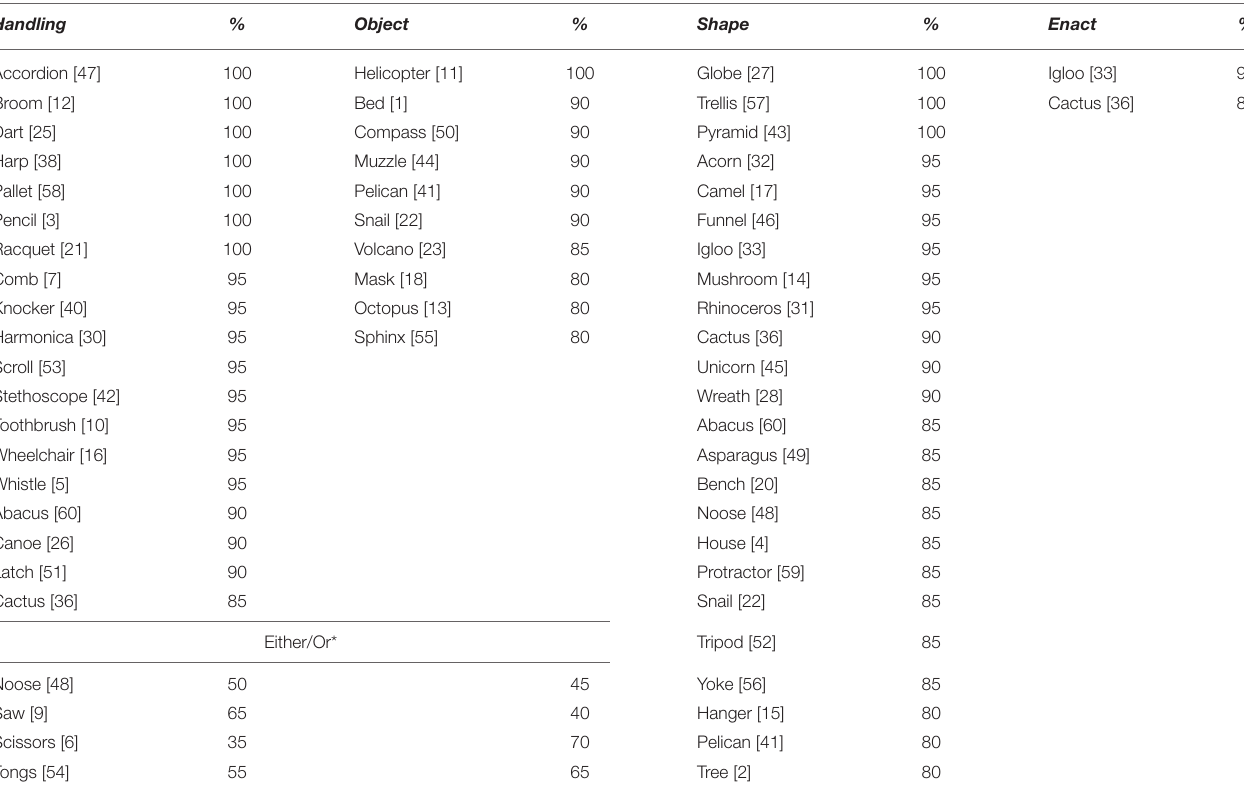
TABLE 2 | Objects per default technique used by percentage of participants (The number between brackets indicates the order of the items in the Boston Naming Test. A higher number is indicative of lower imageability and word frequency). Handling